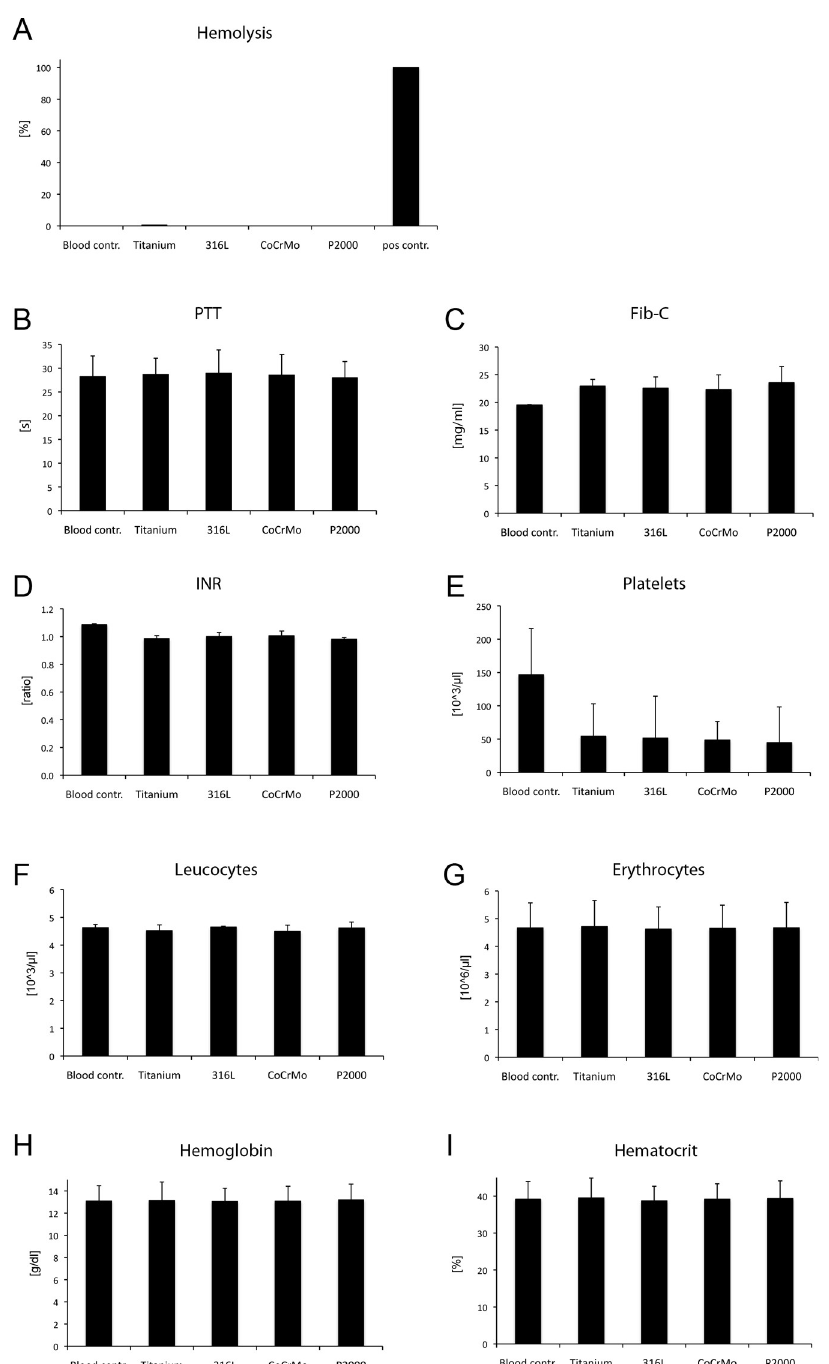
Fig 6. Blood compatibility assay. Testing of blood compatibility by the categories hemolysis (A), coagulation (PTT (B), Fib-C (C), INR (D)), platelet adhesion/activation (platelet count (E)), hematology (leucocytes (F), erythrocytes (G), hemoglobin (H), hematocrit (I)). All tests were performed 60 min after incubation in blood. Blood controls were tubes loaded with blood lacking a metal specimen (= negative control). Hemolysis is shown relatively to the positive control (tubes loaded with 0.4 ml blood and 3.6 ml ddH 2 O = 100%). Data are presented as mean ± S.E.M.